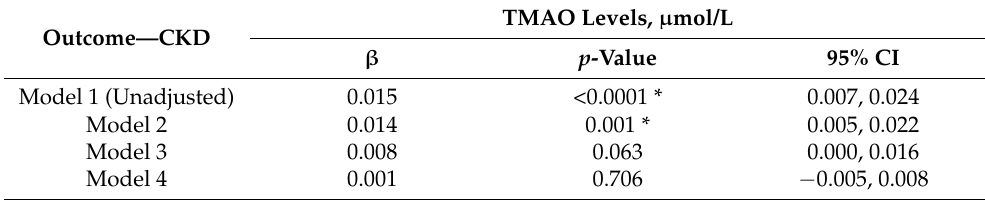
Table 4. Association between plasma TMAO levels and CKD using multiple linear regression models. Outcome—CKD